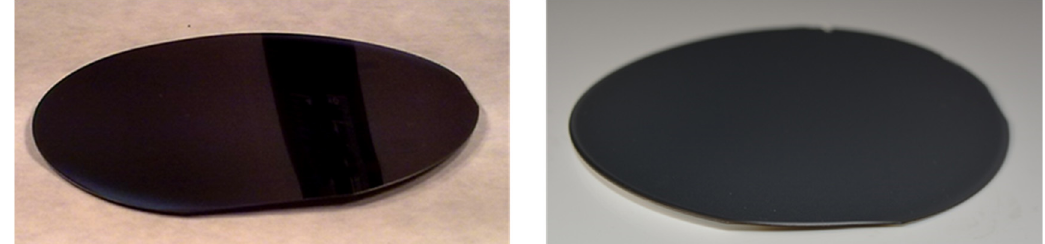
Figure 7. 230 μ m wafer after a not optimized boron diffusion doping (left) and 525 μ m after a thick Figure 7. 230 µ m wafer after a not optimized boron di ff usion doping ( left ) and 525 µ m after a thick (~25 μ m) aluminum sputtering (courtesy of J. Montserrat, IMB-CNM, CSIC). Wafer deformation (~25 µ m) aluminum sputtering ( right ) (courtesy of J. Montserrat, IMB-CNM, CSIC). Wafer deformation (warping) is clearly visible. (warping) is clearly